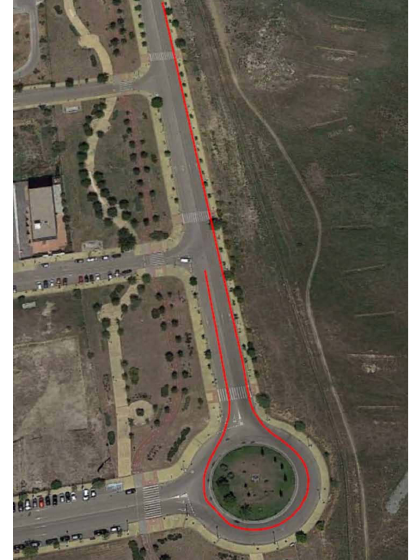
Figure 7. Test 1: Map and vehicle trajectory (Map scale 1:2100 cm).